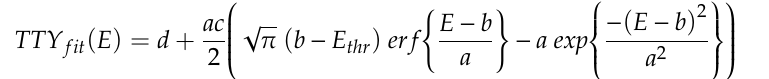
Main γ -Lines [keV] and Intensities 1126 (1.2%), 1157 (1.2%) (97.6%), 1213 (2.4%), 1312